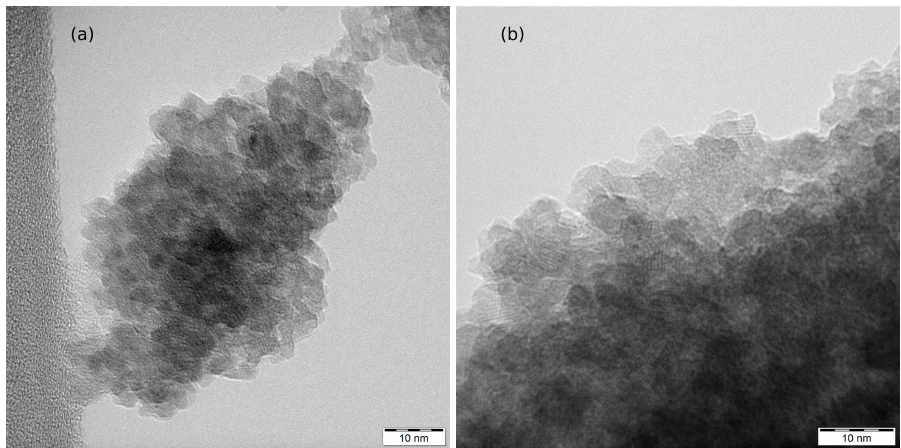
Figure 3. TEM images of measured nanoparticles and their aggregates: ( a ) RT-60 and ( b ) RT-90.